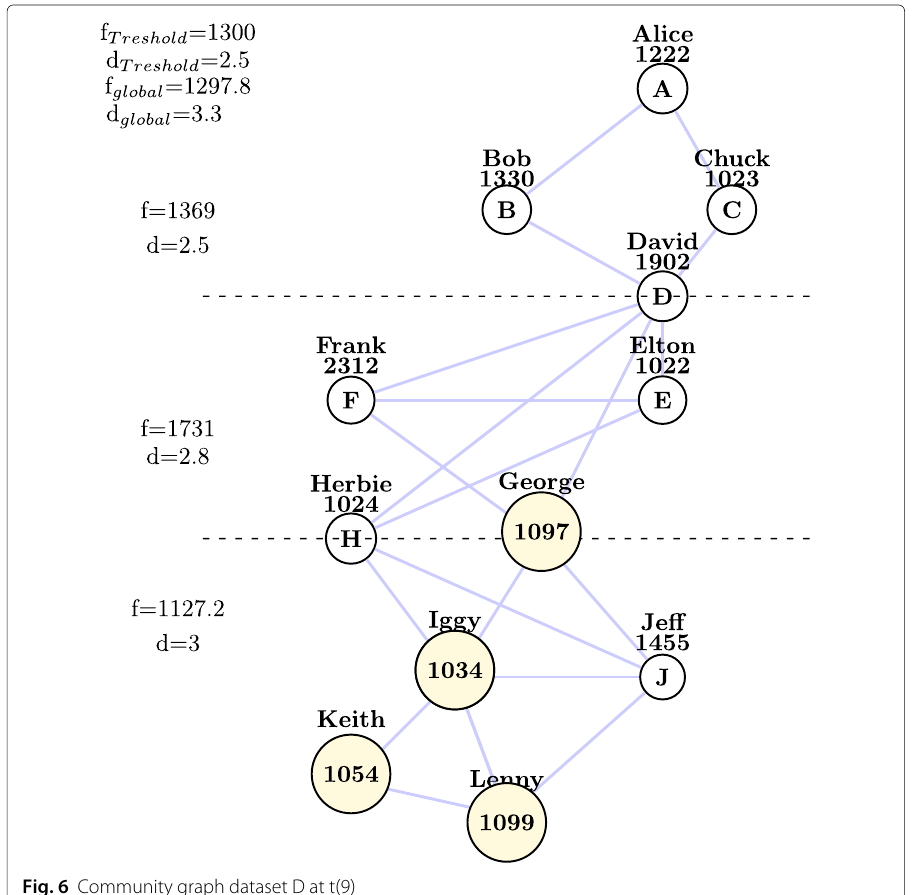
Fig. 6 Community graph dataset D at